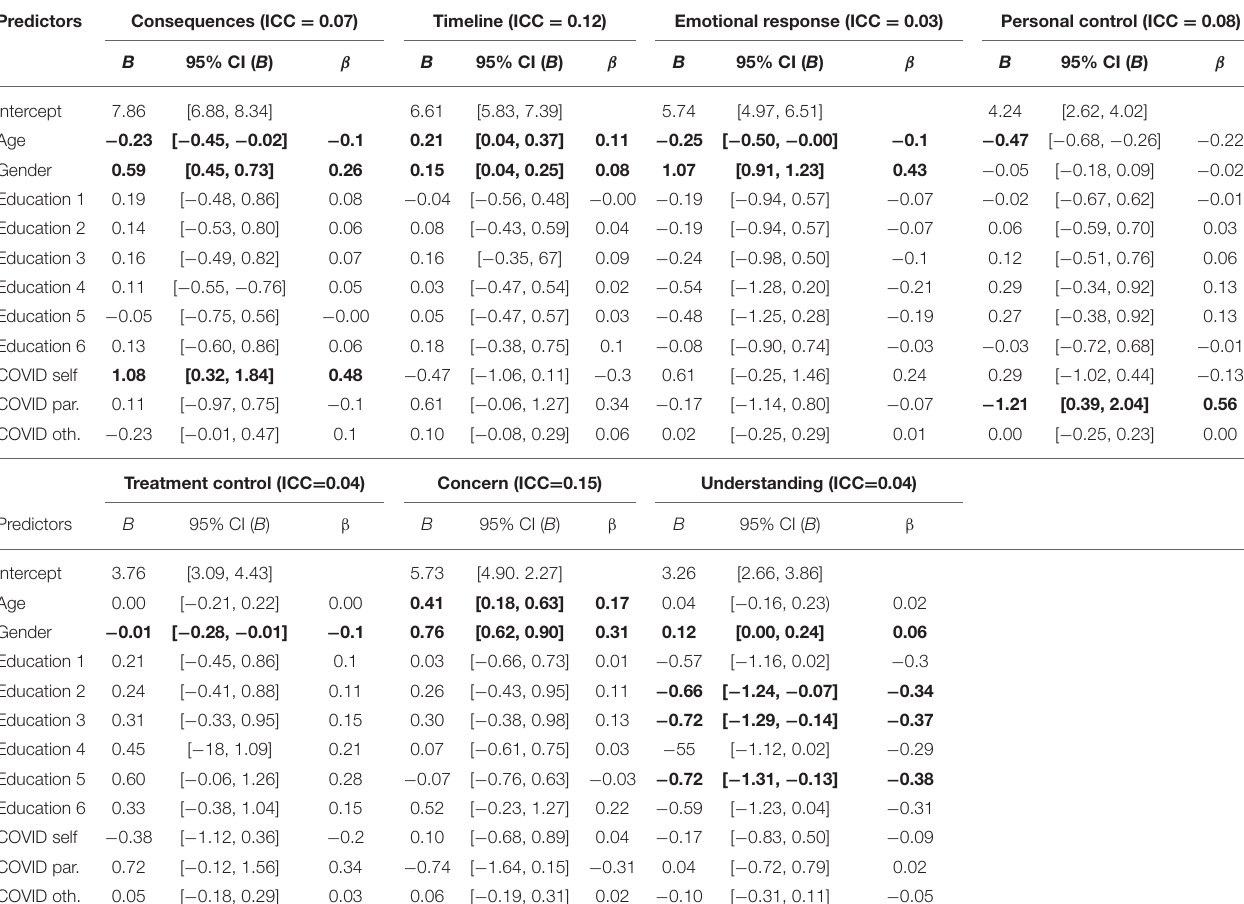
TABLE 5 | Multilevel modeling Regression coefficients, confidence intervals and ICC values for illness perceptions predictors.